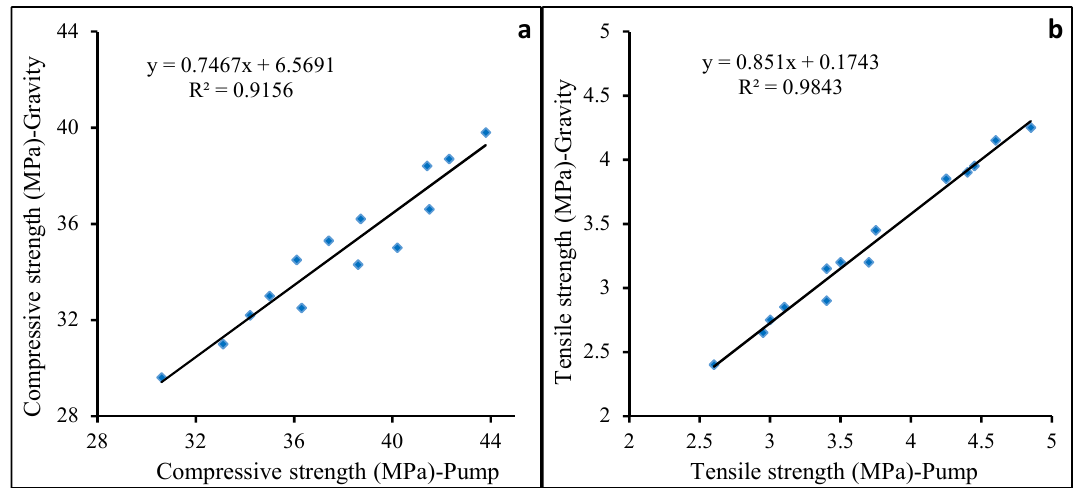
Figure 14. The correlations amongst ( a ) compressive strength and ( b ) tensile strength values of PAFRC specimens by gravity and pumping techniques.